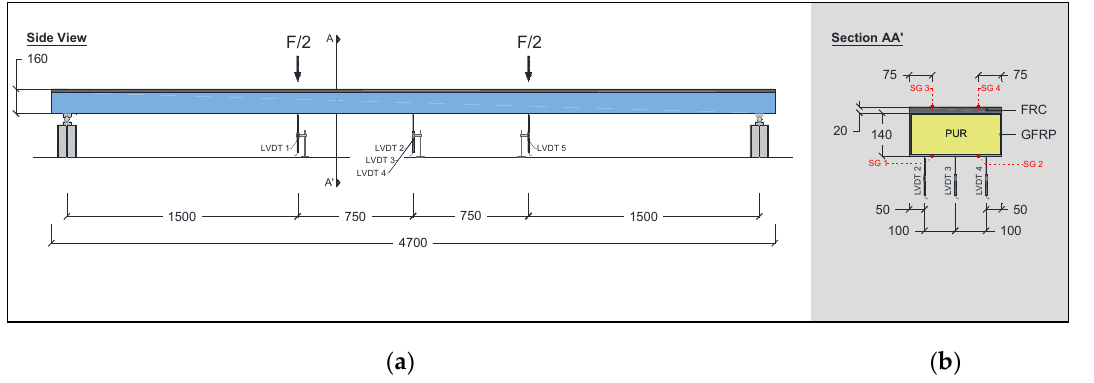
Figure 6. Geometry, test set-up, and instrumentation for the flexural tests up to failure: ( a ) side view and ( b ) cross-section view. Units in mm.